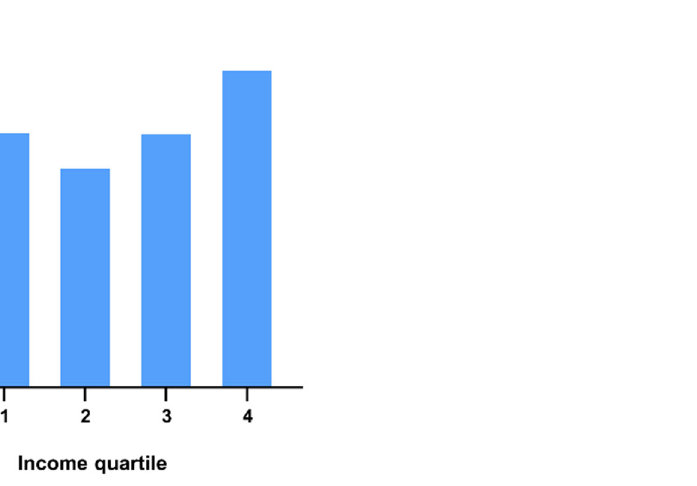
Figure 3. Thalassemia prevalence and incidence by income quartile, where quartile 1 is the lowest of the income distribution and quartile 4 is the highest.